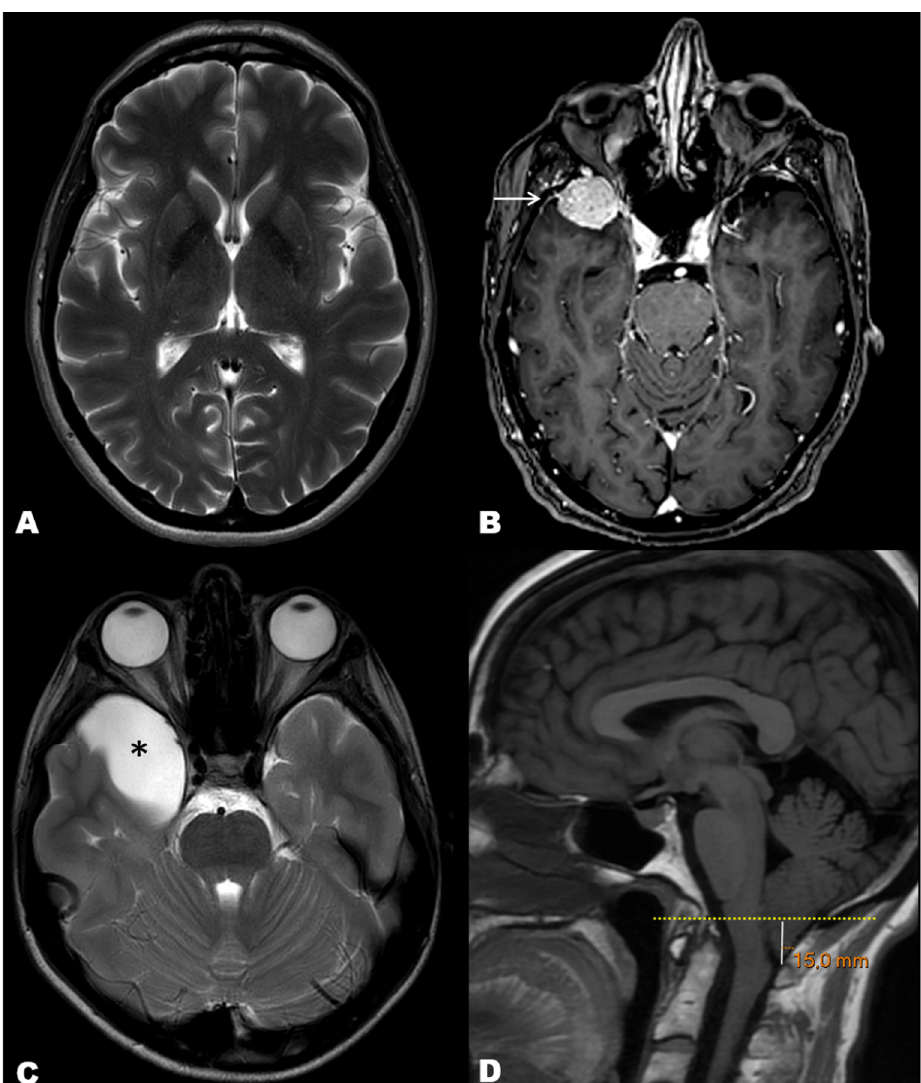
Figure 2. Illustrative cases of our cohort of MRI exams performed to rule out secondary causes of headache. ( A ) T2-weighted axial image in a 65-year-old woman depicting normal brain with no structural abnormalities. ( B ) Post-contrast T1-weighted axial image in a 71-year-old woman showing a right anterior temporal tumor with homogeneous enhancement and ‘dural tail’ sign, consistent with meningioma (arrow). ( C ) T2-weighted axial image in a 10 year-old boy showing a right